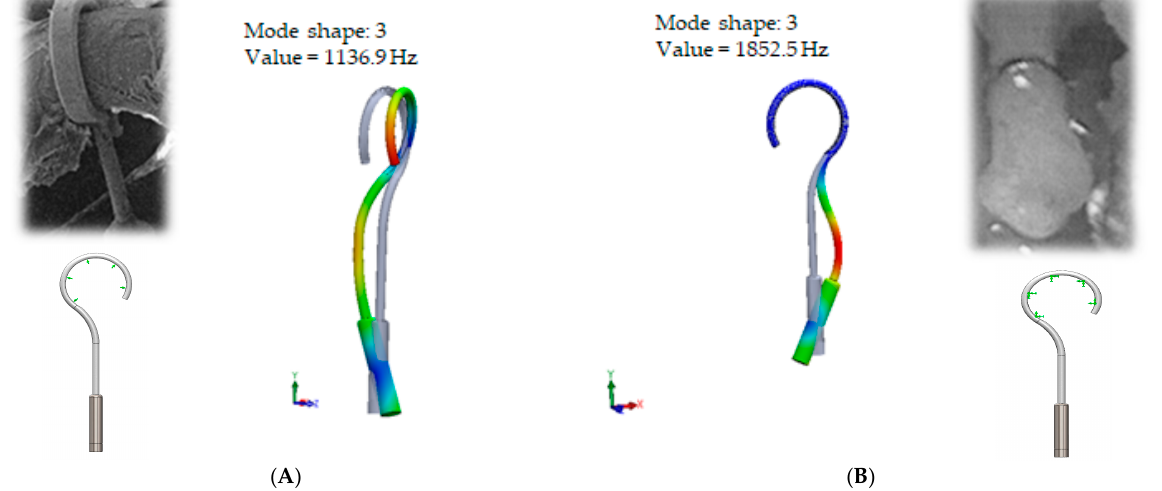
Figure 5. The results of modal analysis: the fixation of the loop of standard stapes prosthesis on the incus long process with free piston. ( A ) standard (target) fixation of the loop of prosthesis. ( B ) over constrained fixation of the loop of prosthesis (for example, in case of necrosis).